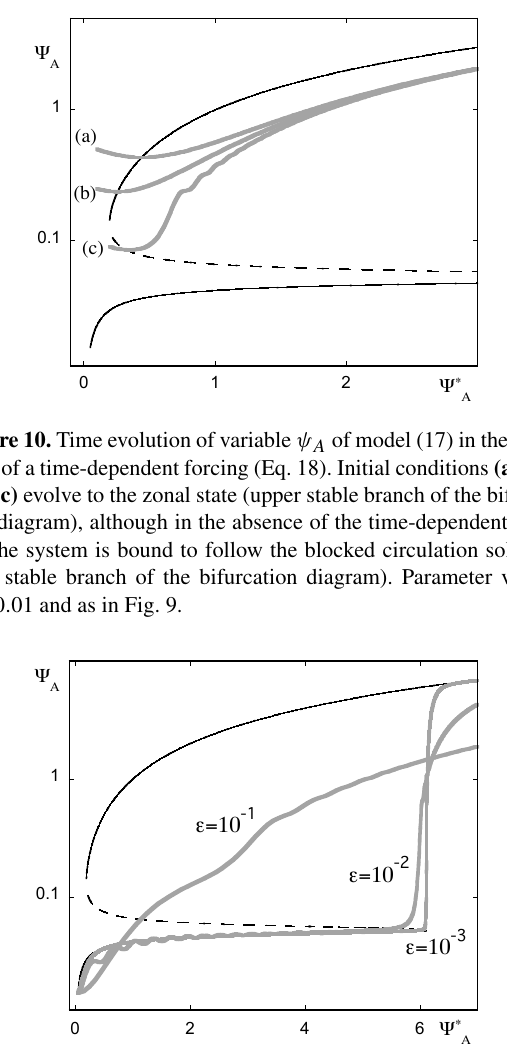
Figure 11. As in Fig. 10 but for initial conditions in the vicinity of the lower stable branch of the bifurcation diagram and three differ- ent (cid:15)